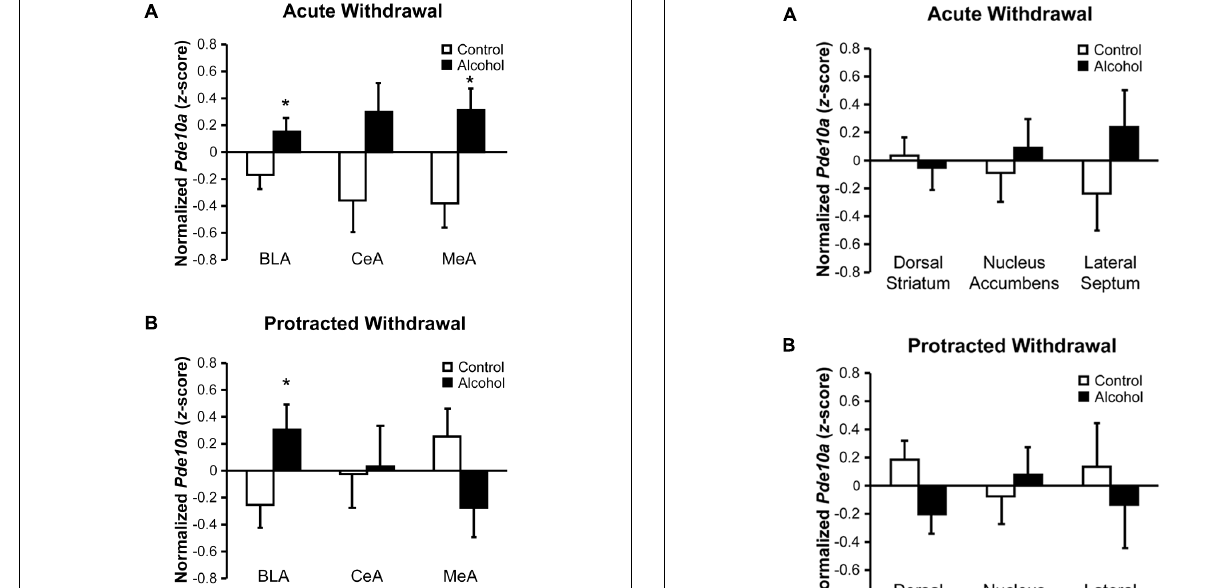
88 kDa band for reliable quantitation in either whole tissue lysates ( Figure 4B ) or in postsynaptic membrane-enriched samples ( Figure 4C ) from the BLA, unlike dorsal striatal